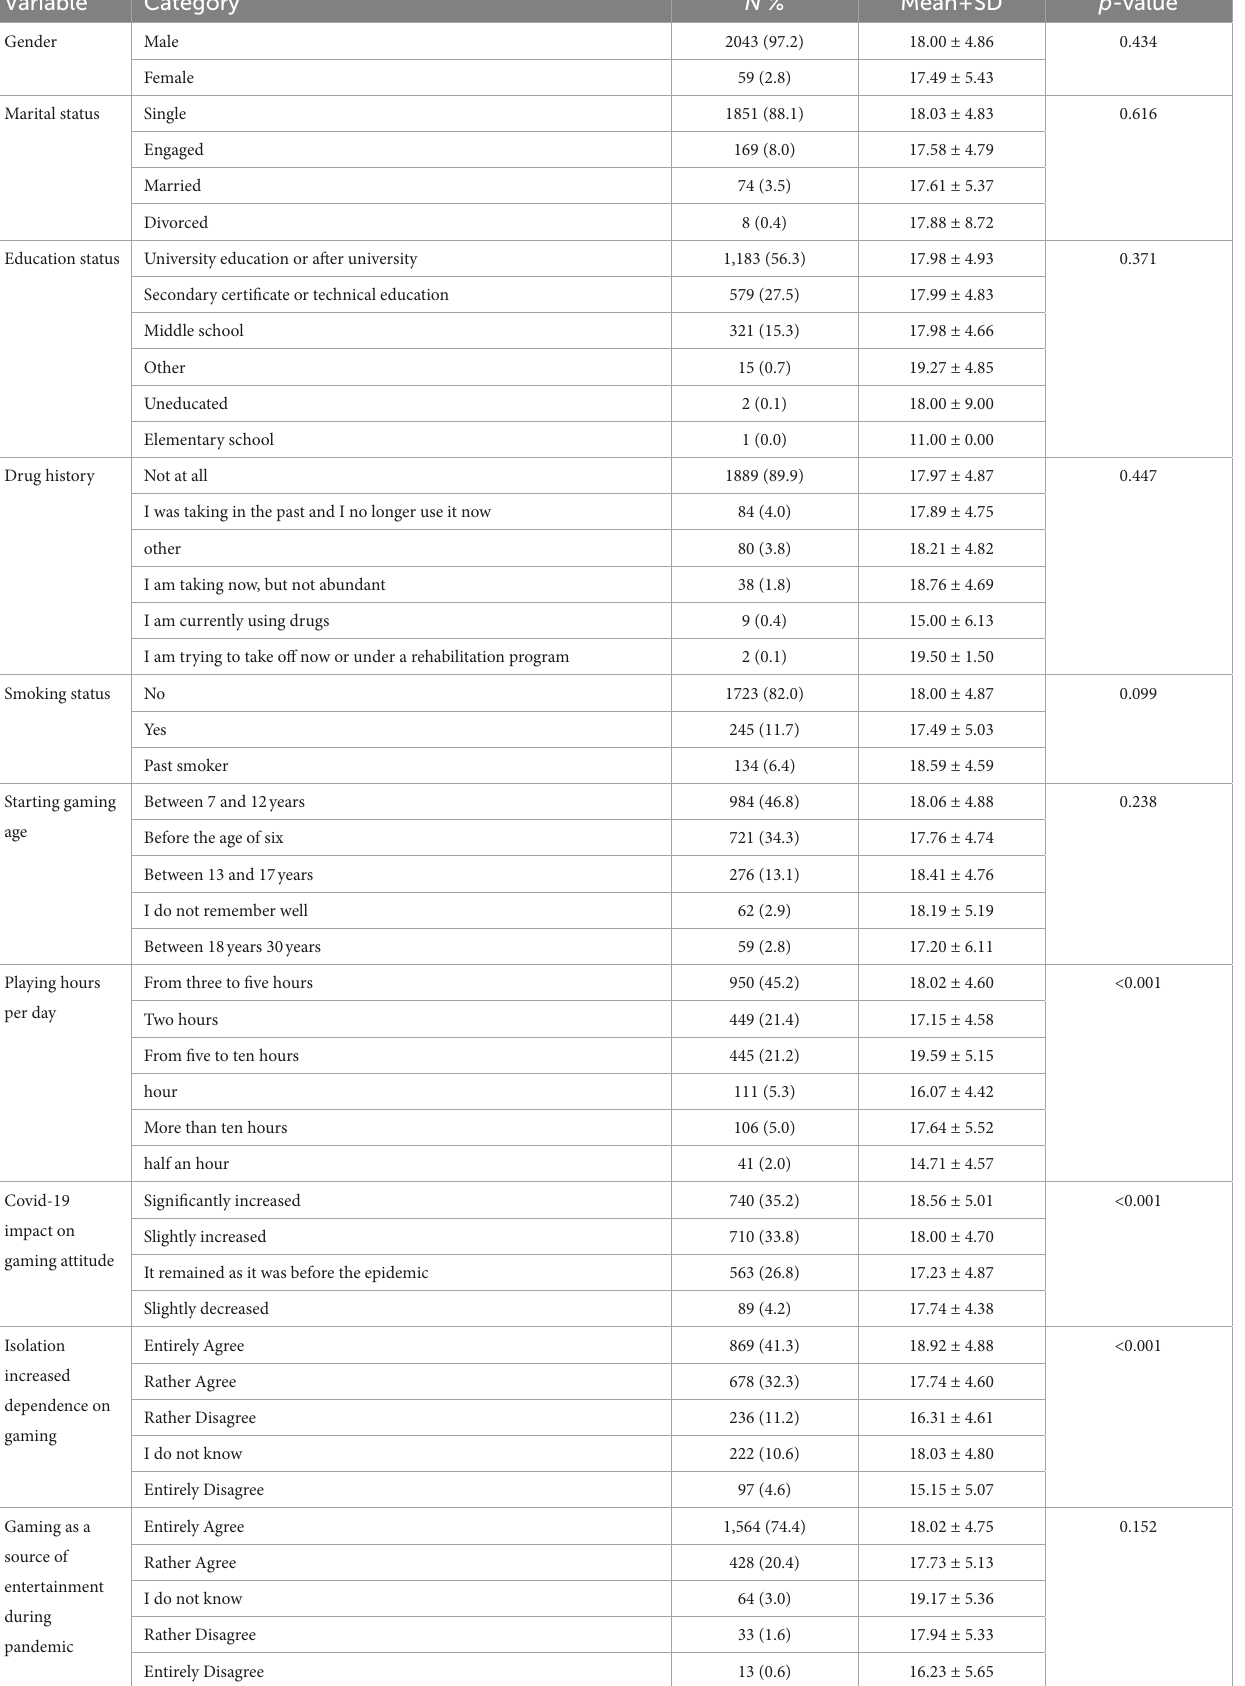
TABLE 3 IGD score and sociodemographic characteristics.